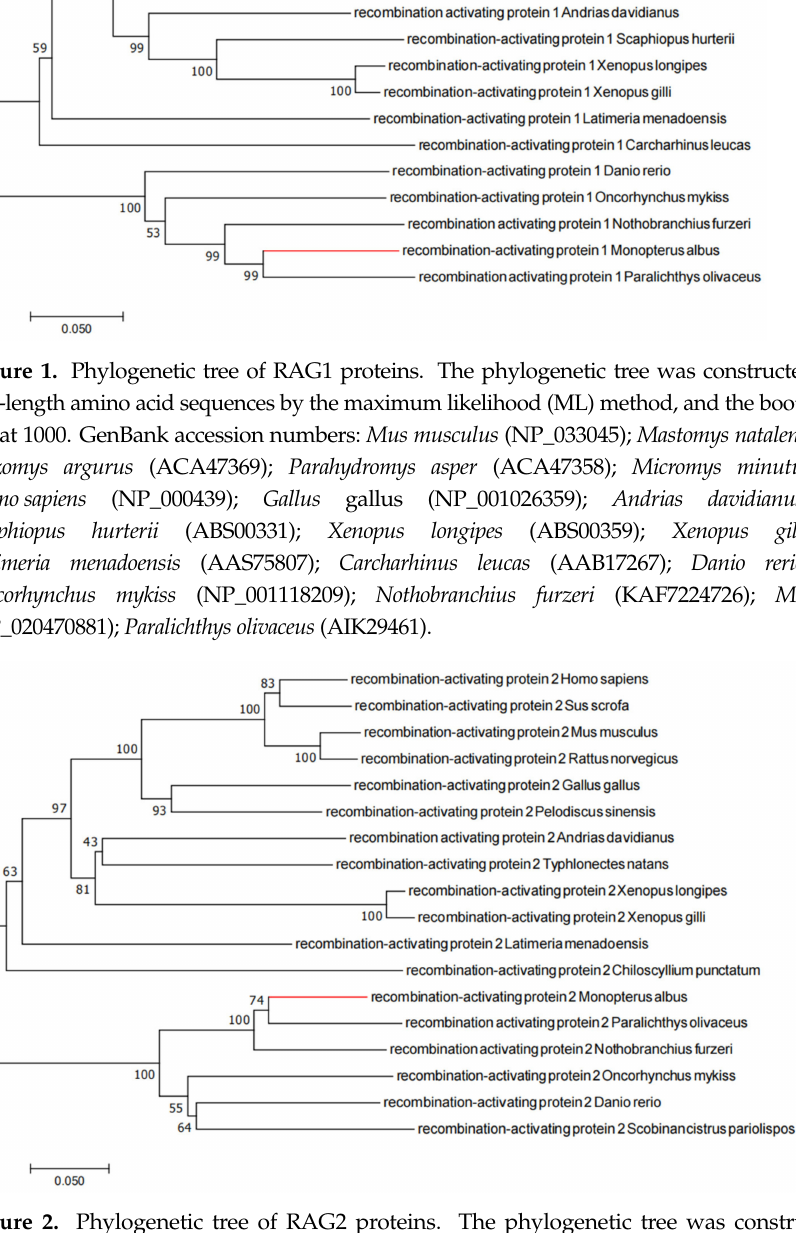
Figure 2. Phylogenetic tree of RAG2 proteins. The phylogenetic tree was constructed based on the full-length amino acid sequences by the maximum likelihood (ML) method, and the boot- strap value was set at 1000. GenBank accession numbers: Homo sapiens (NP_000527); Sus scrofa (NP_001121953); Mus musculus (NP_033046); Rattus norvegicus (NP_001093998); Gallus